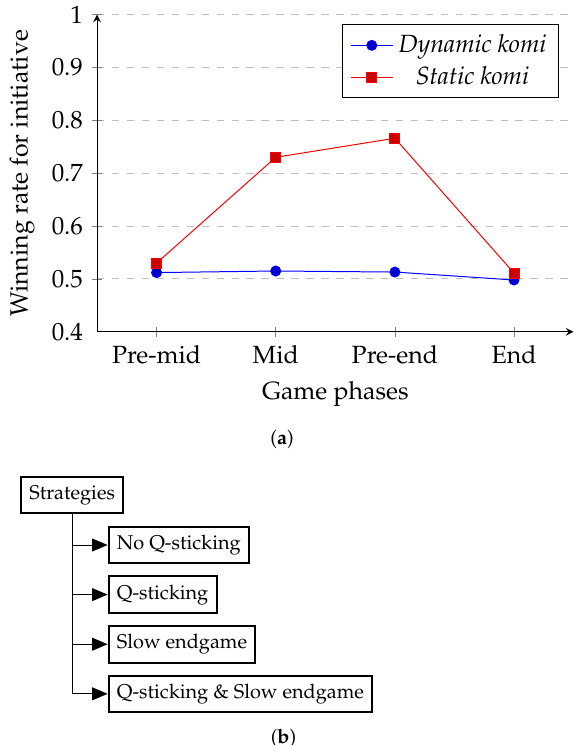
Figure 3. The application of dynamic komi to different game phases, and the adopted endgame strategies. ( a ) Komi variation versus winning probability over different game phases in Scrabble. ( b ) Four variants of Scrabble AI’s endgame strategies.